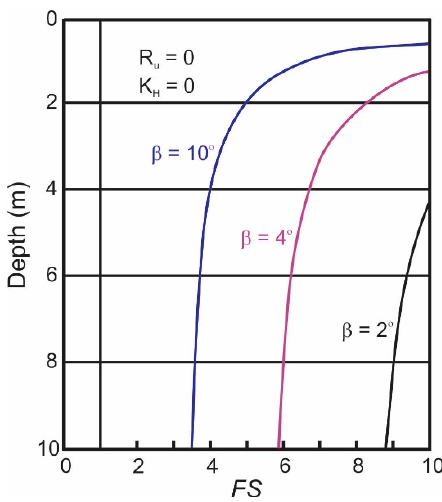
Figure 8. Plot of FS for various slope angles with depth for drained conditions.